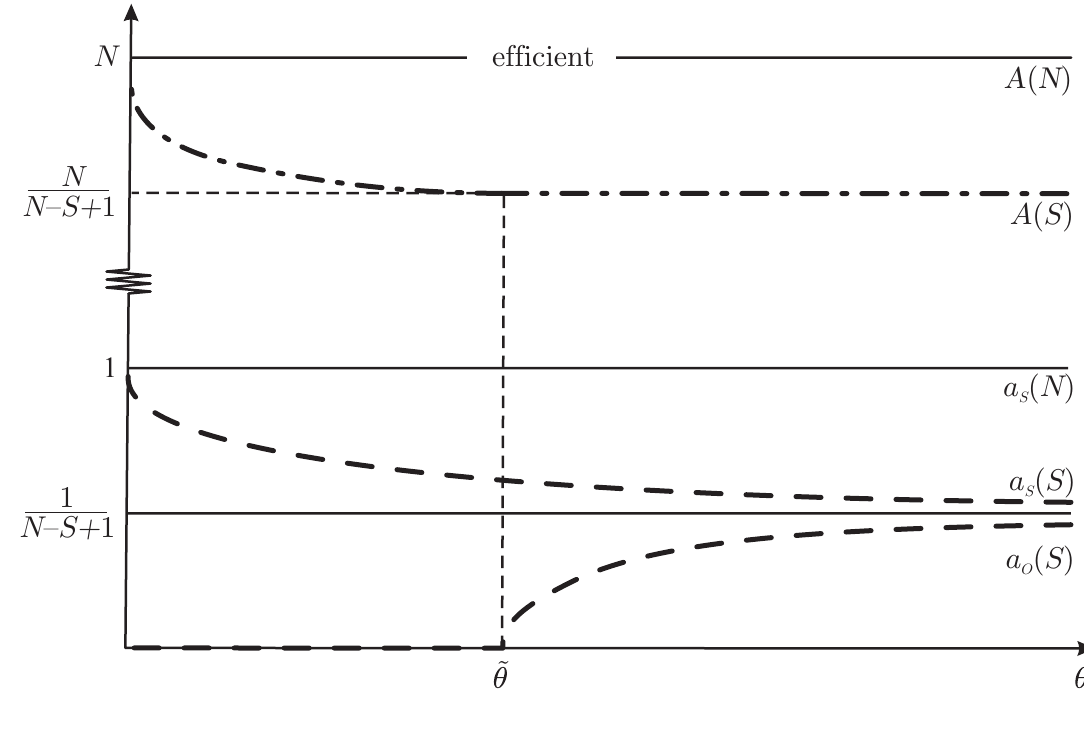
Figure 1. Abatements for coalition size S and N